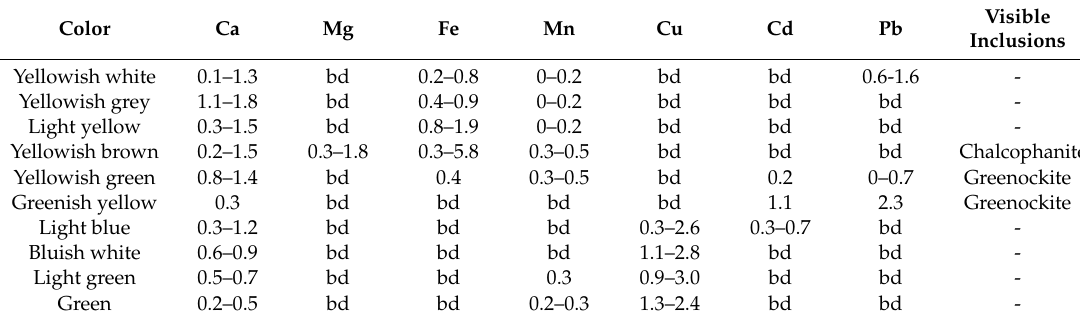
Table 4. Fluctuation of trace element content (wt. %) of selected smithsonite samples from Lavrion (modified after Katerinopoulos et al.